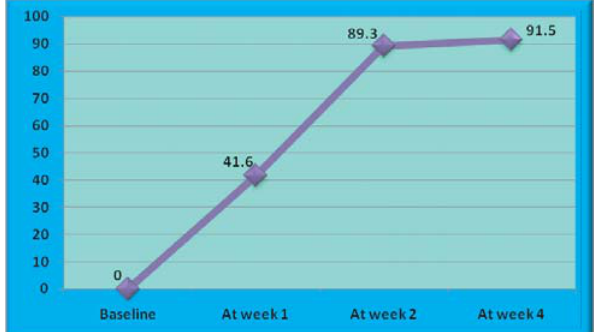
Fig 3. Improvement at different time intervals (n=81) Distribution of patients by global response is shown in Fig 4. Global response was clear in 55 (67.9%) patients, good in 25 (30.9%) patients and fair in 1 (1.2%) patient. Distribution of patients by clinical efficacy is shown in Fig 5. Clinical efficacy was cure in 55 (67.9%) patients, improvement in 25 (30.9%) patients and failure in 1 (1.2%) patient.